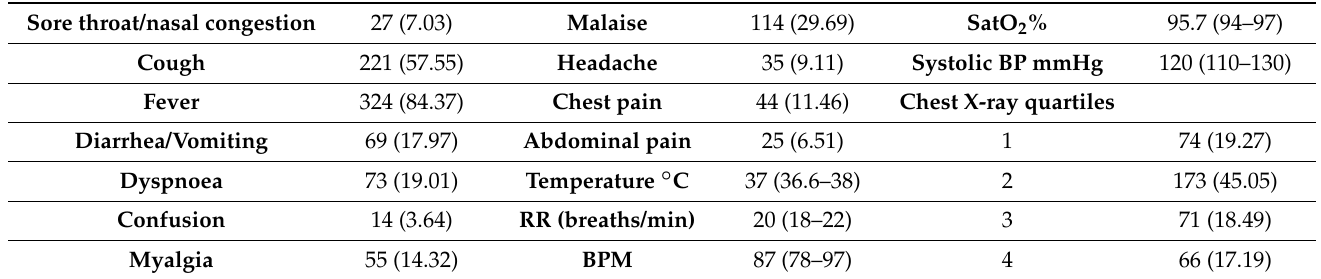
Table 2. Symptoms and signs on